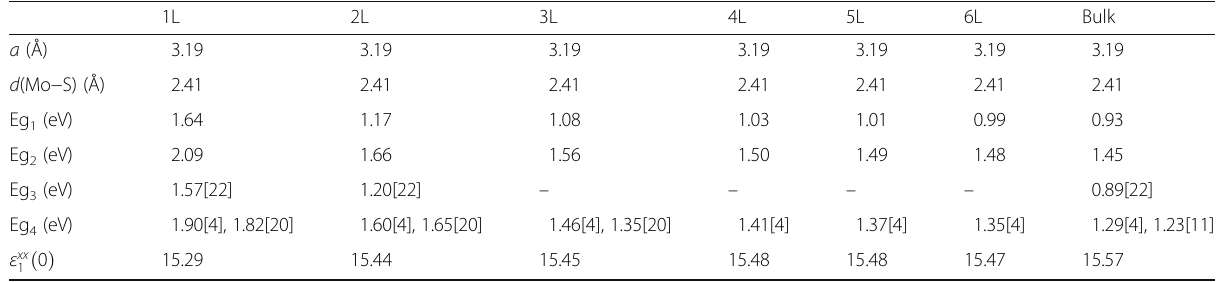
Table 1 Geometrical parameters, band gaps and the static dielectric constants for bulk and multilayer MoS 2 . Eg 1 , Eg 2 , Eg 3 , and Eg 4 are the band gaps calculated by our PBE-D2 method, by our HSE06 method, by the GGA-PW91 method, and from the experimental data, respectively 1L 2L